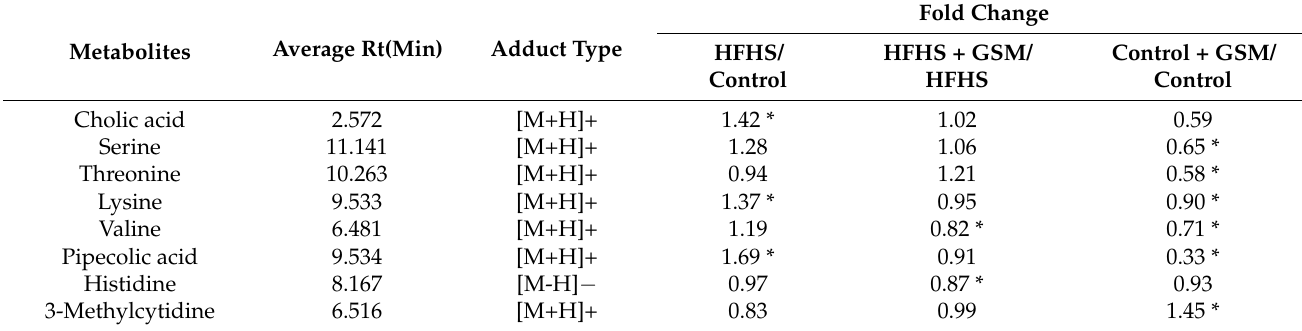
Table 3. Plasma metabolite biomarkers affected by the HFHS diet or GSM treatment in OVX rats.